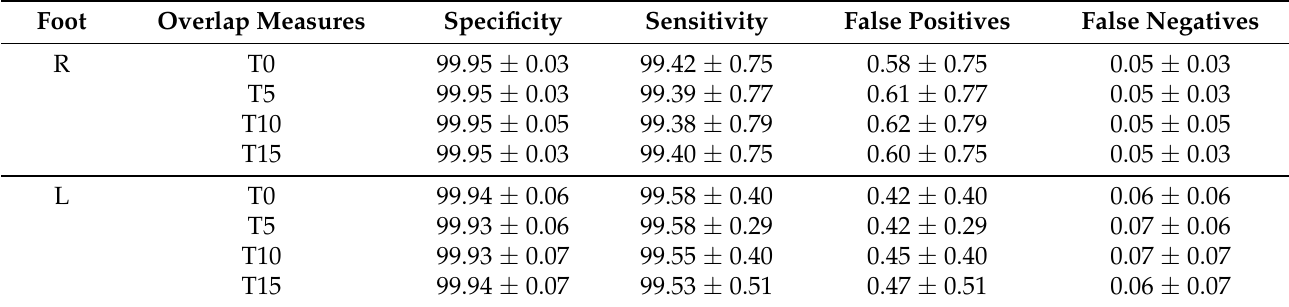
Table 1. Overlap measures at each time point for the ground truth masks associated with the right and left feet. Average values and their corresponding standard deviations are expressed as percentages. Foot Overlap